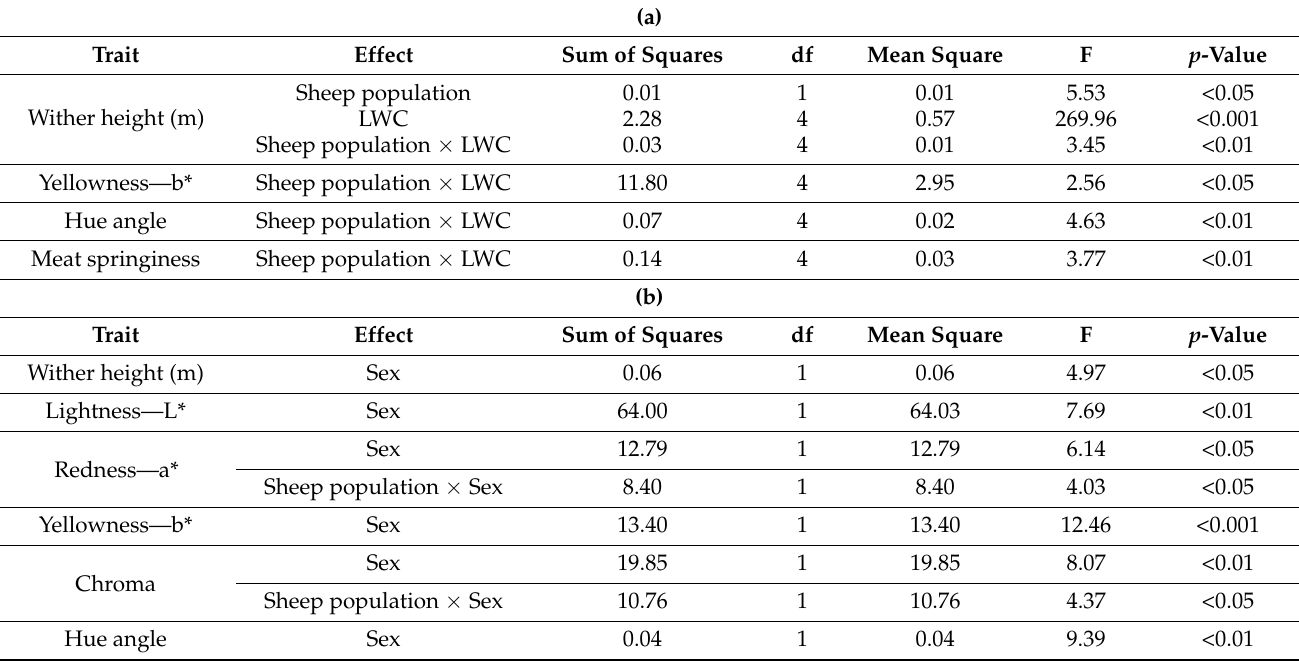
Table 6. ( a ) Statistically significant effects ( p < 0.05) of sheep population (fat-tailed or thin-tailed sheep), live-weight category (LWC—% of mature live weight) and their interaction on studied traits, as estimated based on two-way ANOVA. ( b ) Statistically significant effects ( p < 0.05) of sheep population (fat-tailed or thin-tailed sheep), sex and their interaction on studied traits, as estimated based on two-way